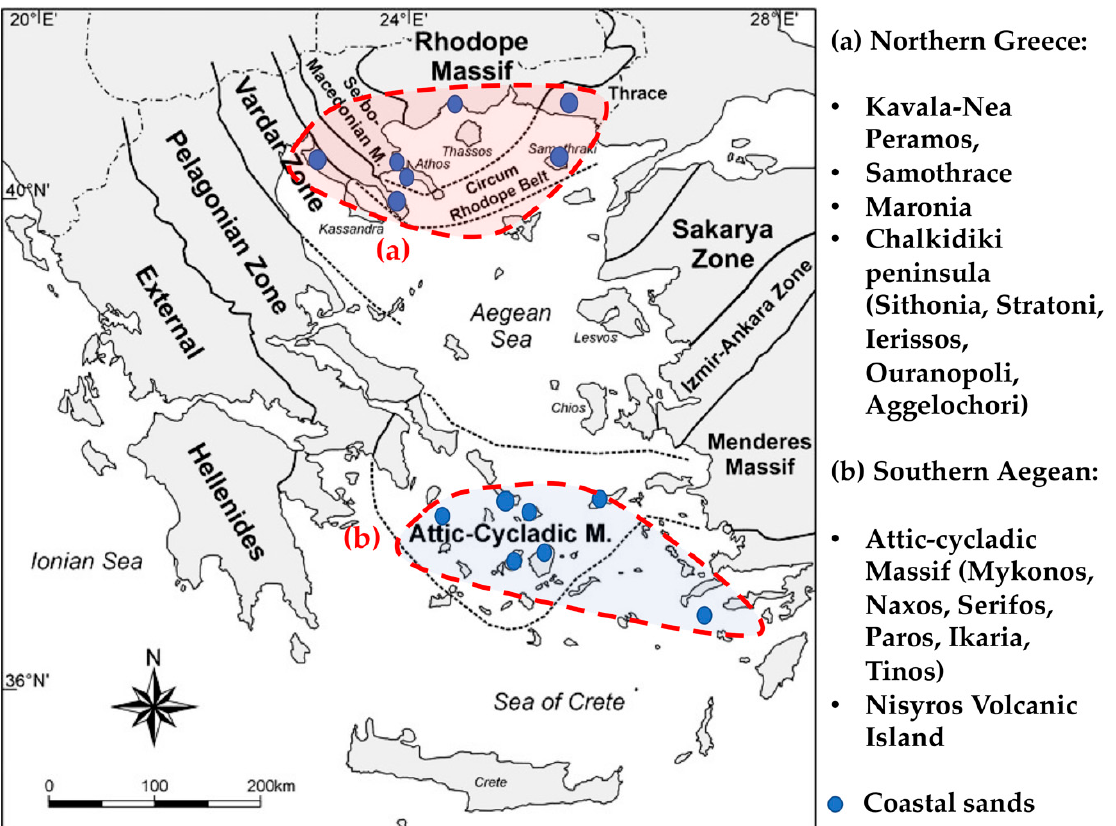
Figure 2. Geographic localities of Greece containing rare earth element (REE)-enriched beach sands as reviewed in this paper. Detailed maps for each of the localities displayed can be found in the Supplementary Materials.